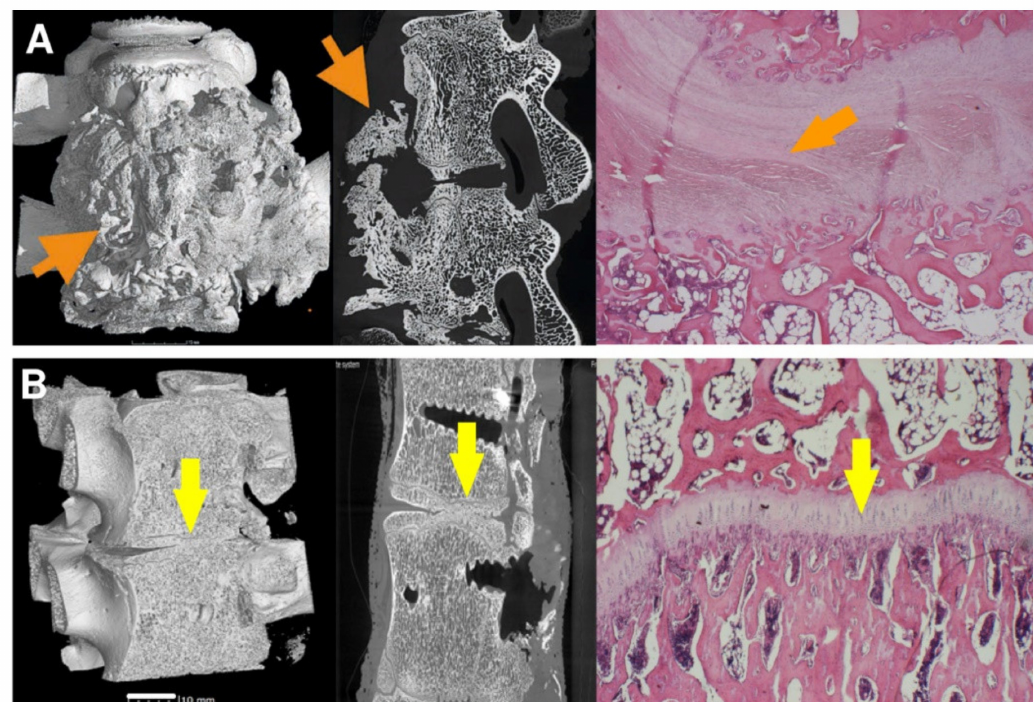
Figure 10. The vertebrae fusion of cadaveric lumbar spines is presented by micro-CT and histology images after 16 weeks after surgery for subgroups A2 ( A ) and B2 ( B ). Left pictures represent micro-CT 3D visualization, the middle images show micro-CT cross-section, and the right ones correspond to the histological images. On the micro-CT images, clearly visible nonunion outgrowth can be seen in Group A2 (autograft) ( A , orange arrows), while the bone fusion of the intervertebral areas without connective tissue outgrowth marked with yellow arrows of group B2 (sample with bioresorbable hybrid implant (BHI)) is observed in figure ( B ). micro-CT images very well corresponded to the histological pictures, where the central fibrous cartilage (light pink) layer is in the middle of the bone tissue ( A , right image), whereas endochondral ossification with new bone and without fibrous tissue was formed after BHI implantation ( B , right image, yellow arrow). Histological decalcified samples were stained by hematoxylin-eosin to observe the nucleus of the cells (blue-violet), the cytoplasm (pink), collagen connective tissue (light pink), cartilage cells (dark blue), and muscle